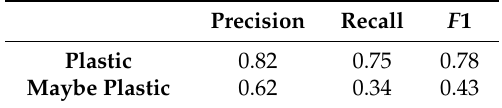
Figure 9. Relationship between the spatial resolution (cm/pixel) and the area covered by an image gathered by the DJI Mavic ProCamera (grid mission with an 80 % overlap).